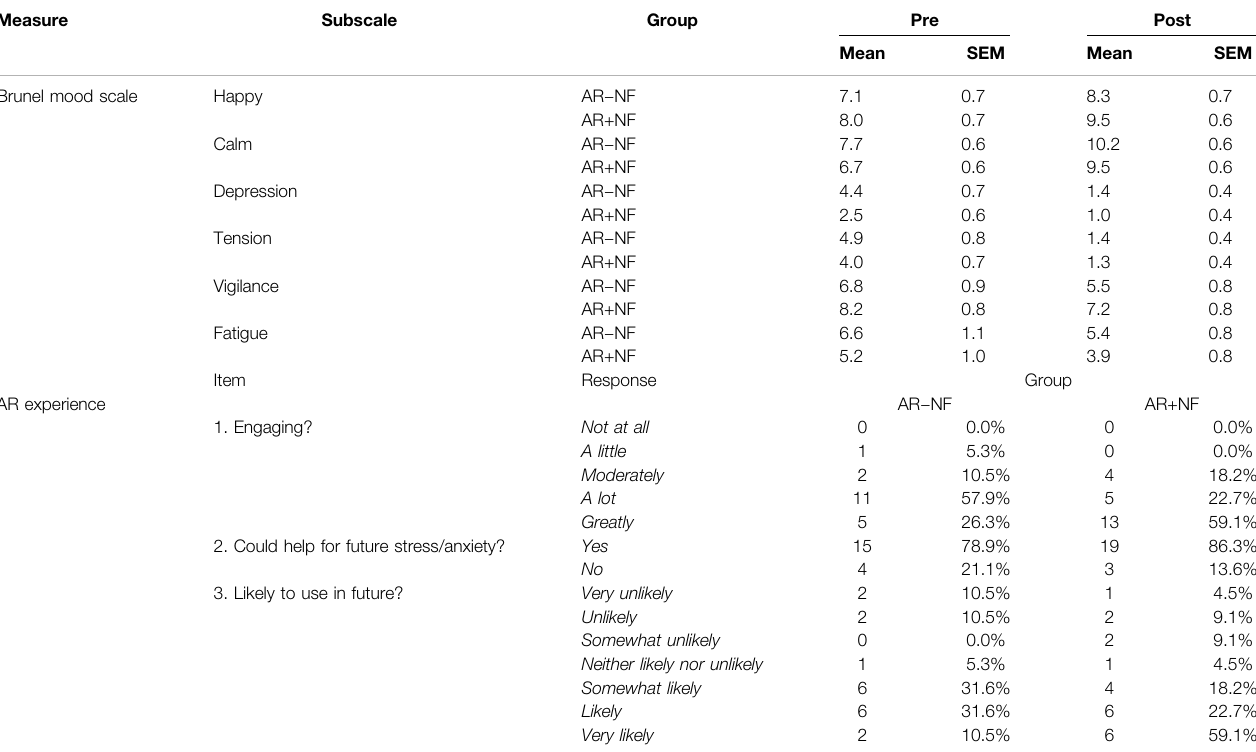
TABLE 2 | Means and standard error estimates of questionnaire measures.